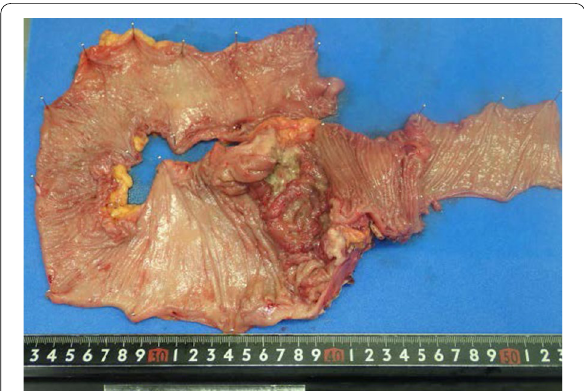
Fig. 3 Macroscopically, the tumor was a circumferential type 2 tumor of the